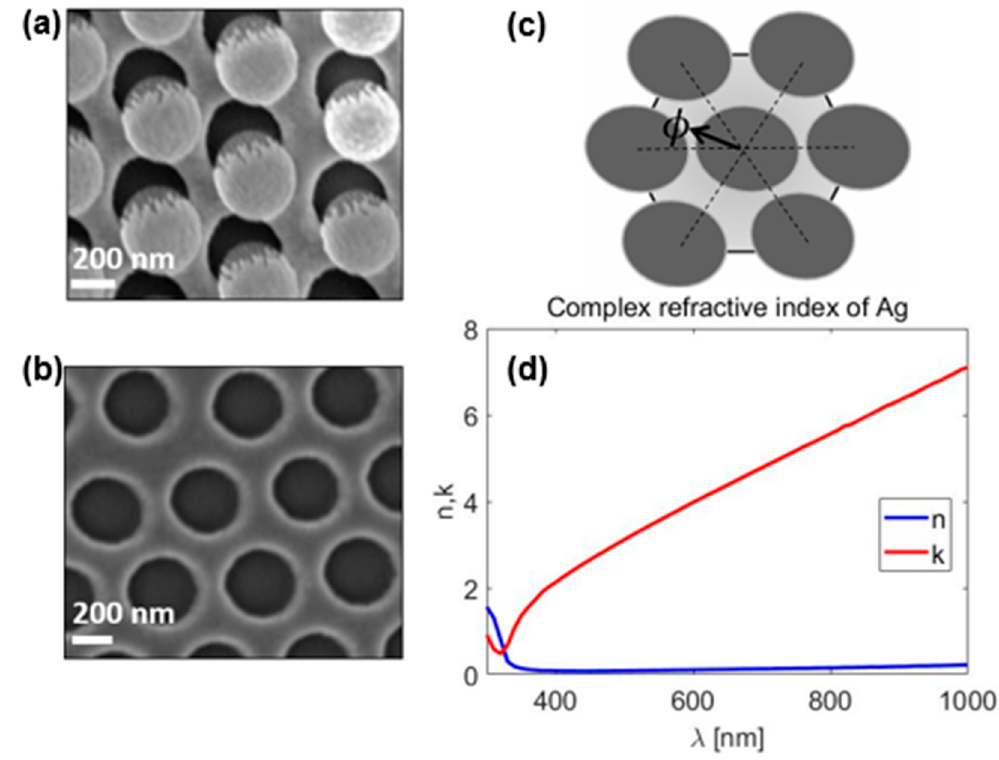
Figure 1. SEM image of the sample ( a ) before, and ( b ) after the PSN removal. ( c ) Schematic of the asymmetry due to the in-plane tilting of the elliptical nanoholes. ( d ) Ellipsometry characterization of the reference Ag